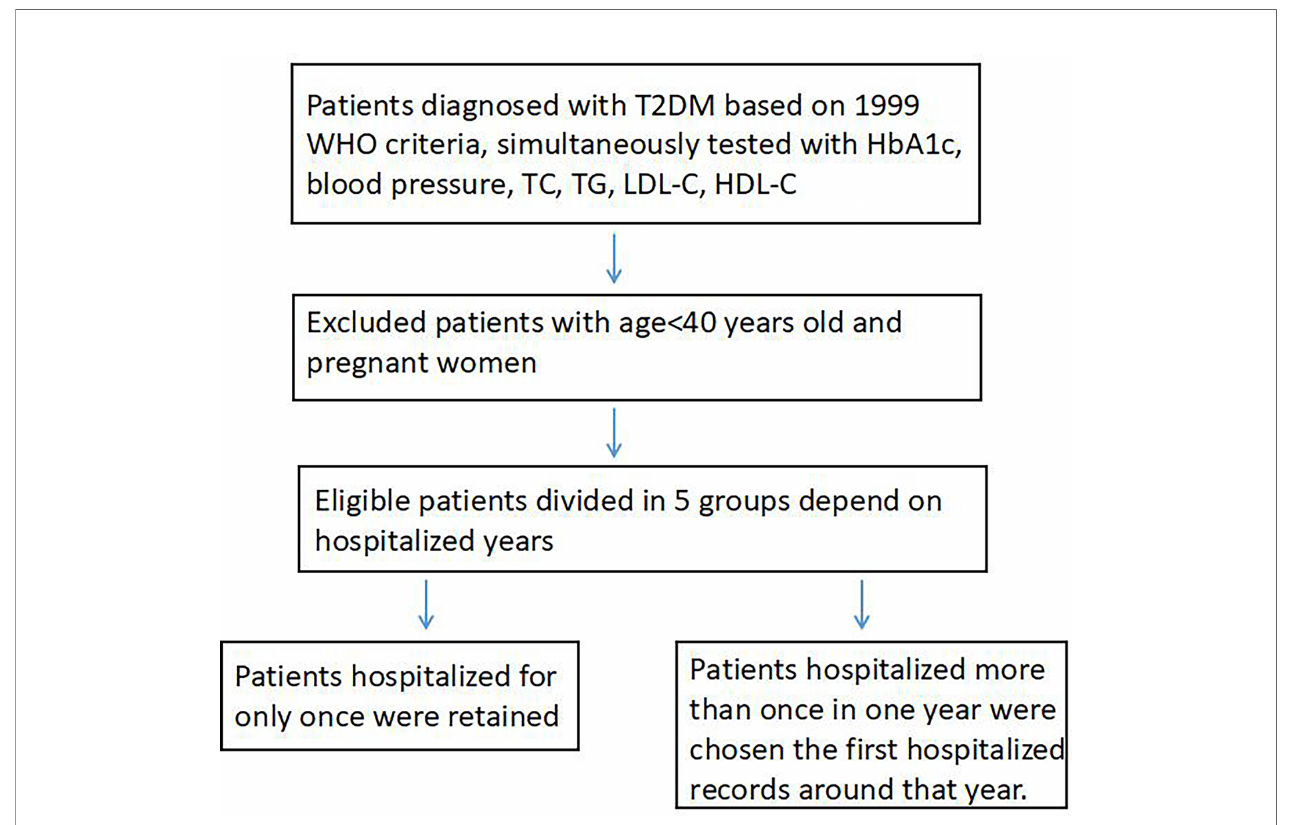
FIGURE 1 | Participant fl ow